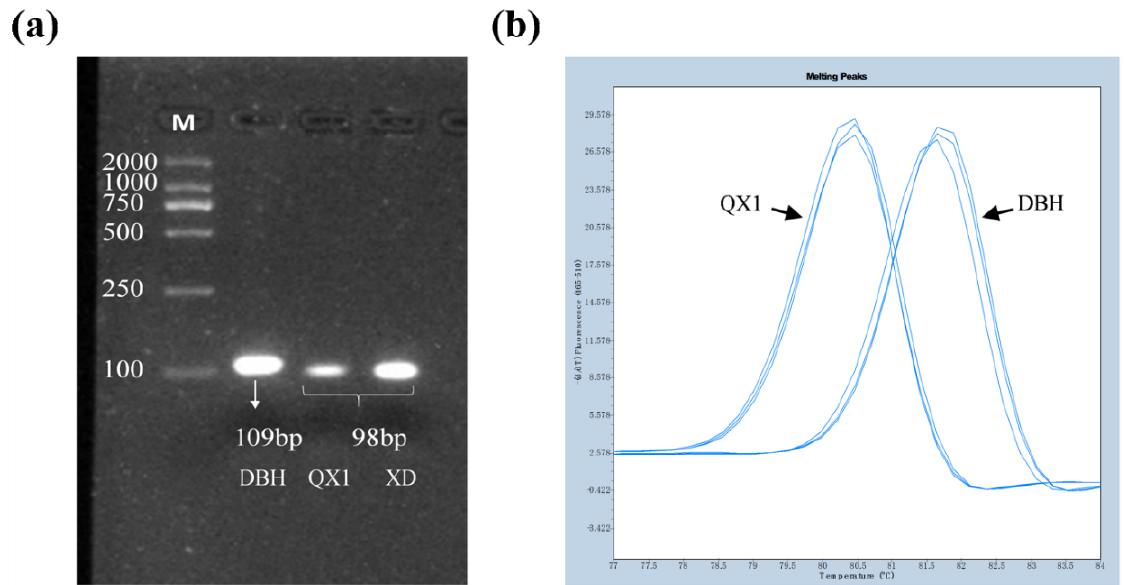
Figure 5. Development of molecular markers for the hybrid parents (DBH/QX1). ( a ) Agarose gel electrophoresis results indicated the amplified target sequences were 98 bp for the aromatic soybean varieties (QX1 and XD) and 109 bp for the non-aromatic soybean variety (DBH). ( b ) HRM peak profiles for DBH (82 °C) and QX1 (80 °C).